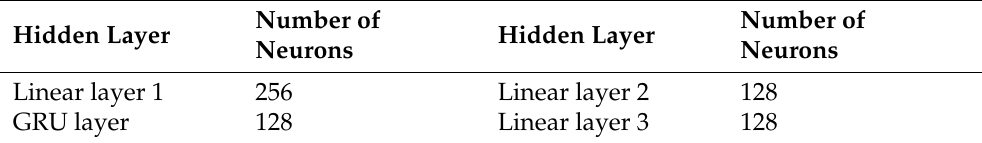
Table 5. Neuron number of our